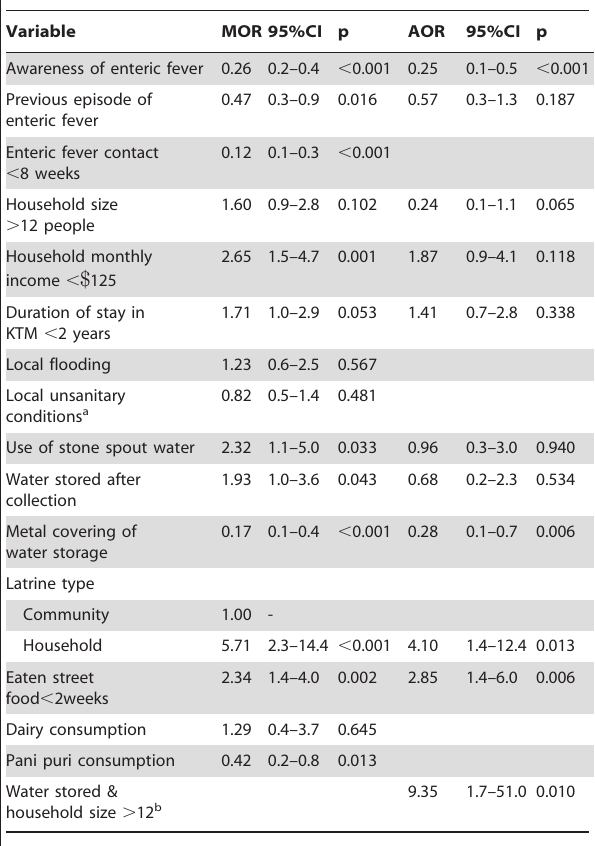
Table 2. Matched and adjusted odds ratios for various exposures for enteric fever cases and matched controls in Kathmandu, Nepal,